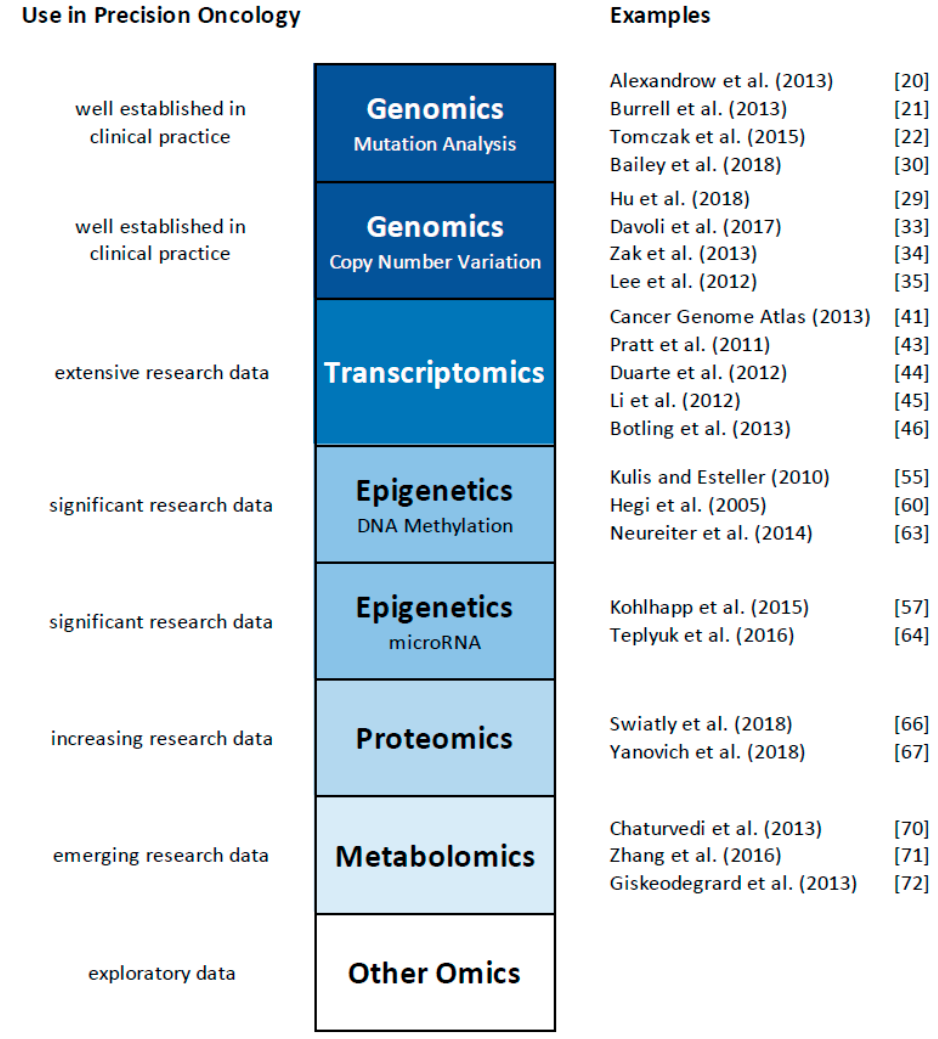
Figure 1. Summary of the applications of individual omics technologies to study cancer and other human disorders.